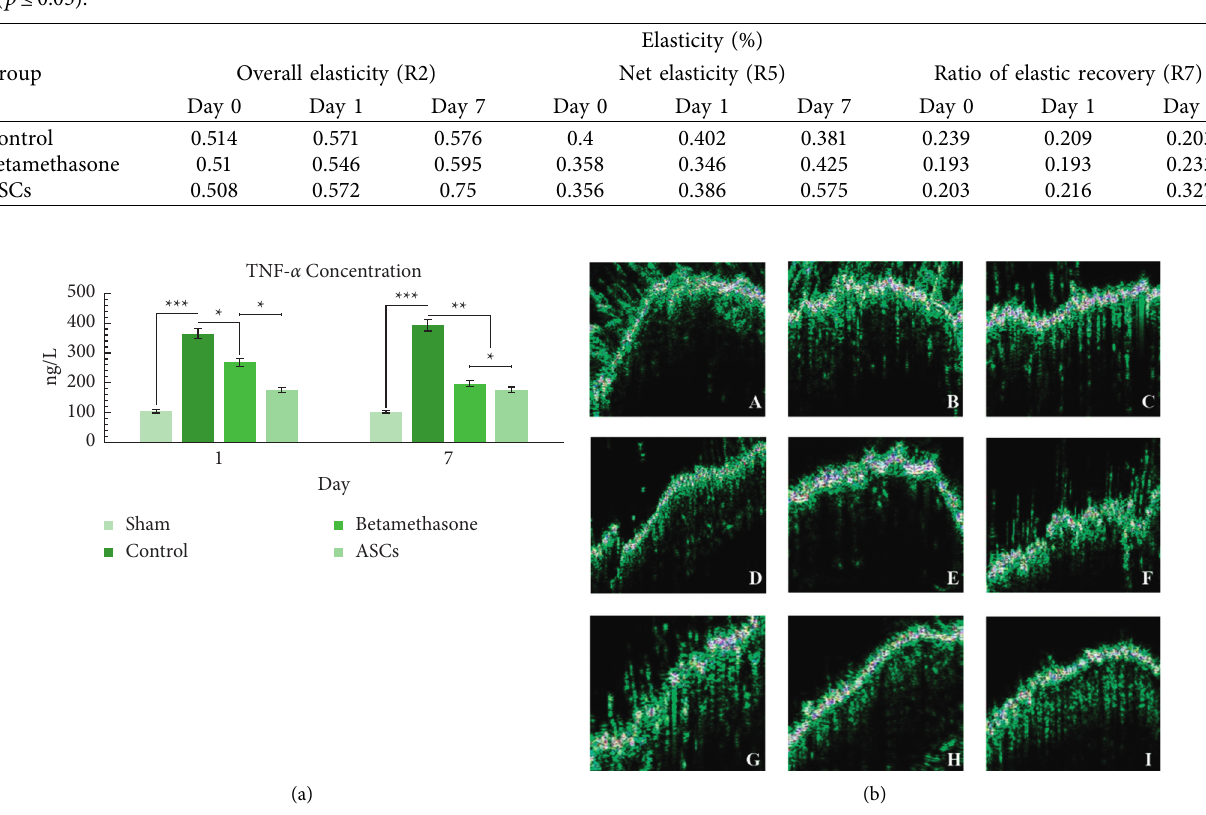
Figure 4: (a) Samples of sham, control, betamethasone, and ASC groups were collected and analyzed by TNF- α on days 1 and 7. Error bar: mean ± SD ( ∗ p ≤ 0.05, ∗∗ p ≤ 0.01, ∗∗∗ p ≤ 0.001). (b) Thickness and density were evaluated with ultrasonography images in treated (betamethasone and ASC groups) and control groups on days 0, 1, and 7. Ultrasonography image (A; 0, B; 1, and C; day 7) in control, (D; 0,